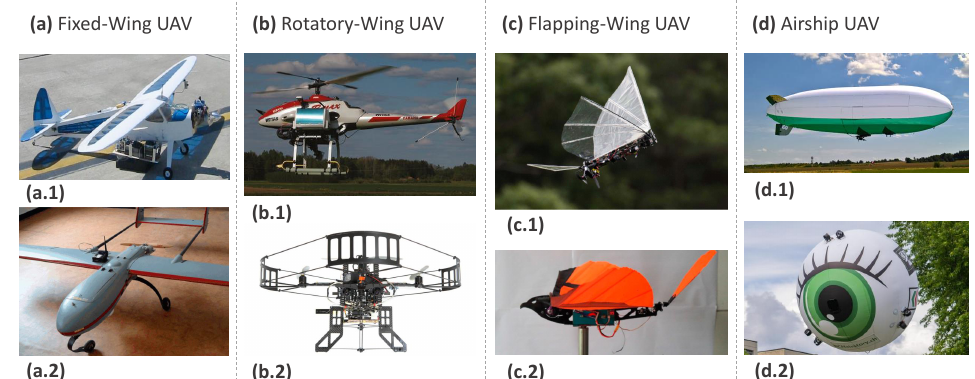
Figure 5. Classes of Unmanned Aerial Vehicles (UAVs): Examples of commercial and prototype aircraft. ( a ) fixed-wing UAV: a.1 Sig rascal model (reprinted from [53] by permission from American Society